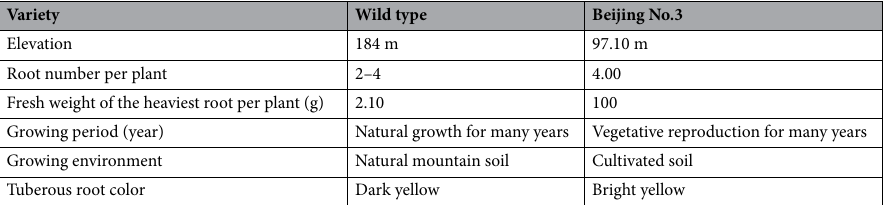
Table 1. Phenotypic analysis of two